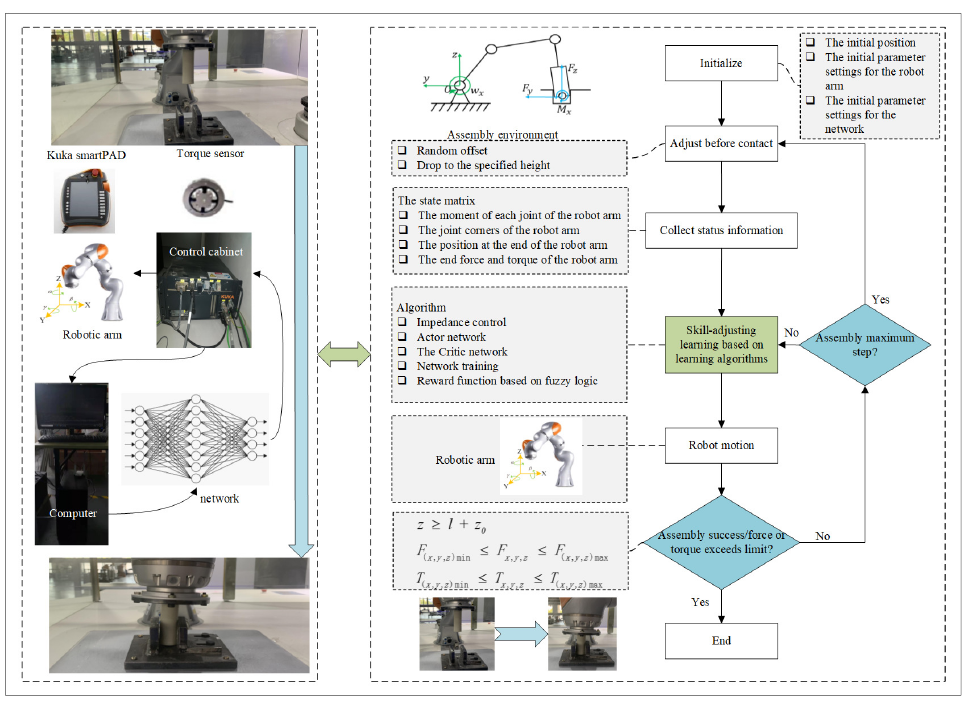
Figure 1. The framework of the proposed